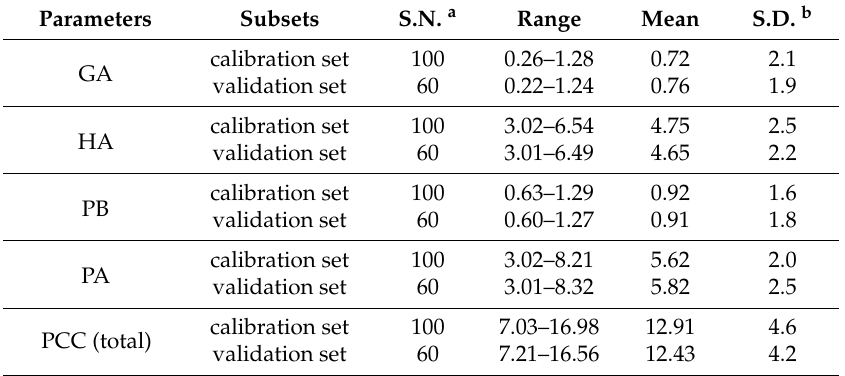
Table 4. Division and parameters of samples in the calibration and validation set